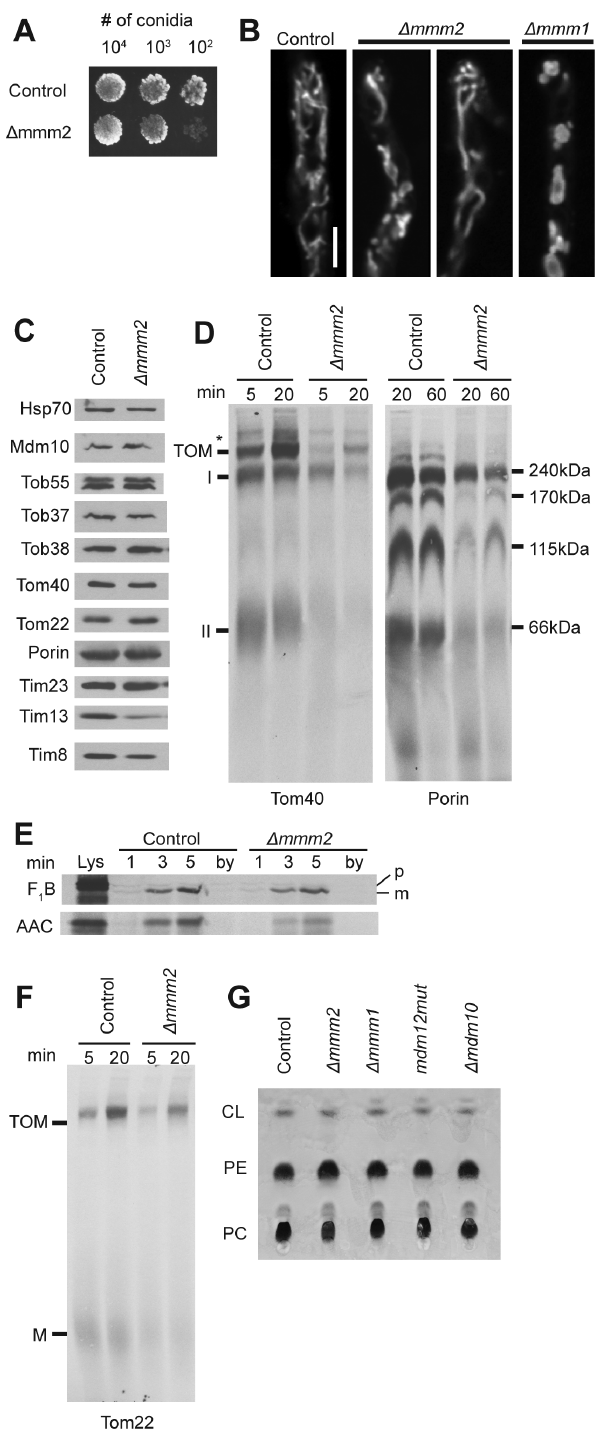
Figure 6. Characterization of the mmm2 knockout strain. A. Measurement of growth rate as in Figure 3C. B. Visualization of mitochondria as in Figure 3D. C. Mitochondria (30 ug) isolated from the control and mutant strains were subjected to SDS-PAGE, transferred to nitrocellulose and analyzed on Western blots with antibodies to the indicated proteins (30 m g mitochondrial protein per lane). D. Assembly of radiolabeled b -barrel proteins Tom40 and porin as in Figure 4A and B, respectively. E. Radiolabeled F 1 b and AAC were imported into mitochondria isolated from the indicated strains. After import, the mitochondria were treated with proteinase K, reisolated,